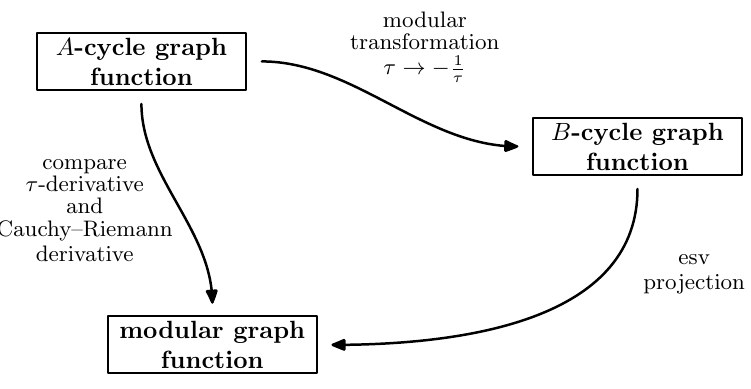
Figure 3 . Two paths for the calculation of modular graph